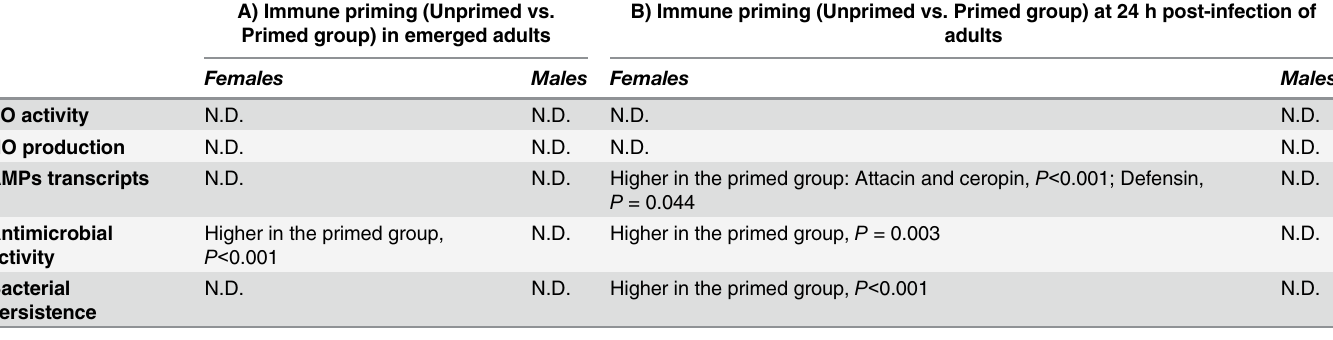
Table 1. Immune response of adult males and females when previously primed at the larval stage, compared to the groups not exposed to E . coli (unprimed) at the larval stage. A) Response of emerged adult; B) response of adults after infection with E . coli